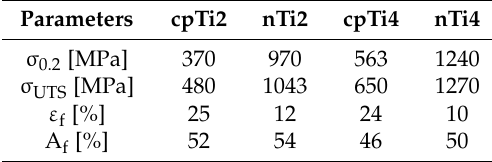
Figure 1. Grain size of ( a ) basic pure titanium (cpTi) and ( b ) nanostructured titanium (nTi) material. Table 1. Mechanical properties of basic and nanostructured bulk materials. σ 0.2 : yield strength, σ UTS : ultimate tensile strength, ε f : elongation to failure, A f : reduction of area.